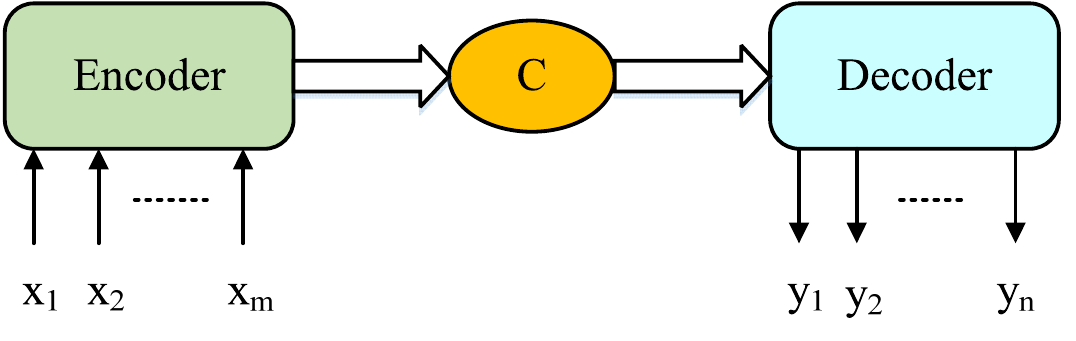
Figure 5. Seq2seq Structure.